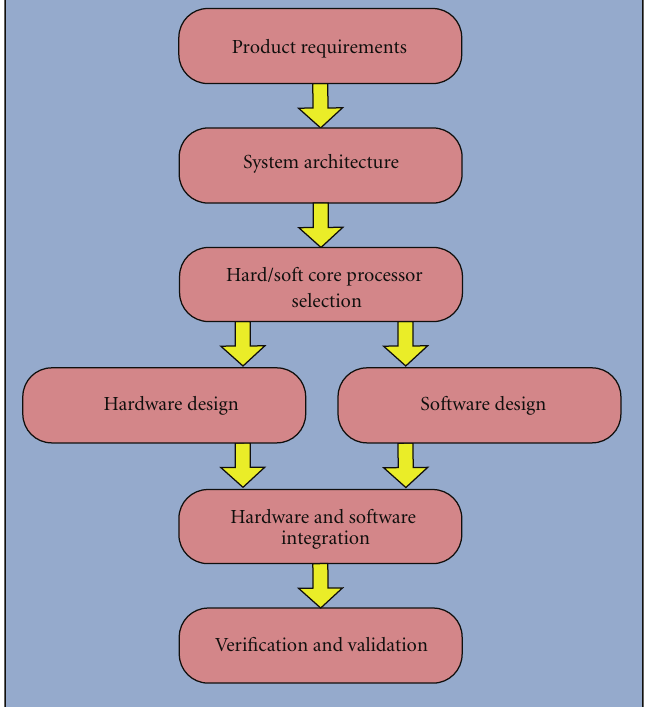
Figure 1: Design process of an embedded system.